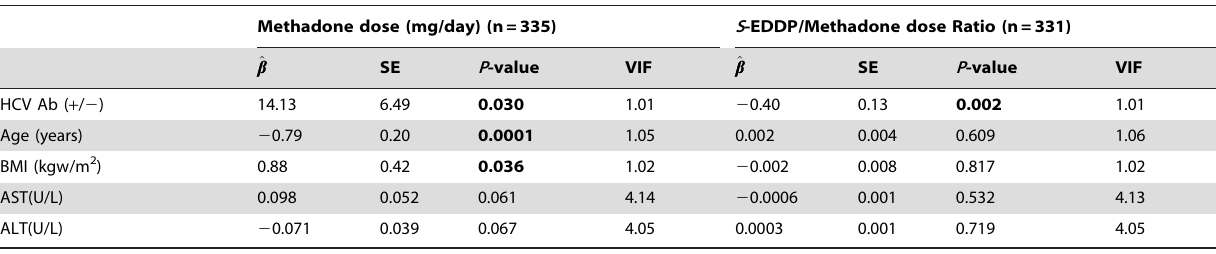
Methadone dose (mg/day) (n=335) S -EDDP/Methadone dose Ratio